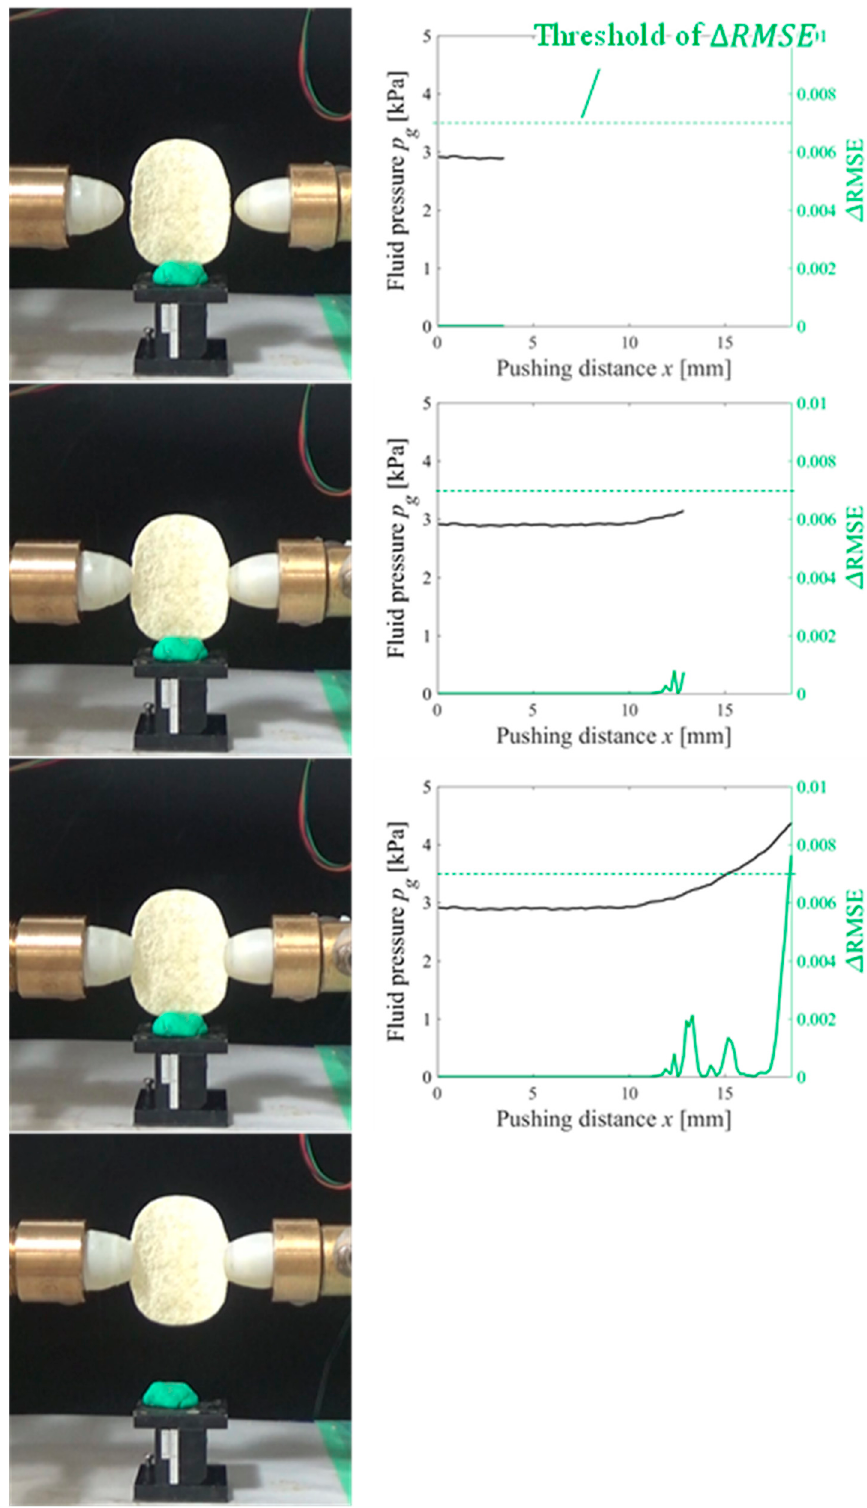
Figure 13. Overview of the grasping test (potato chip target)